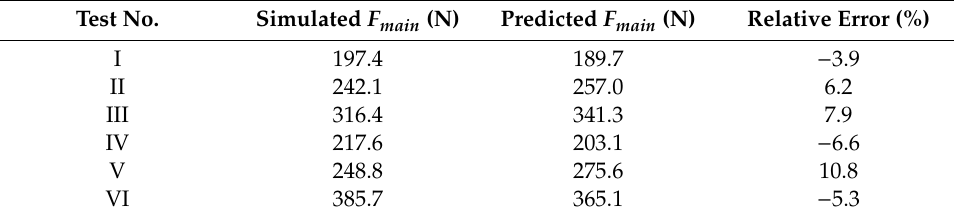
Table 7. Confirmation of the prediction model for F main .